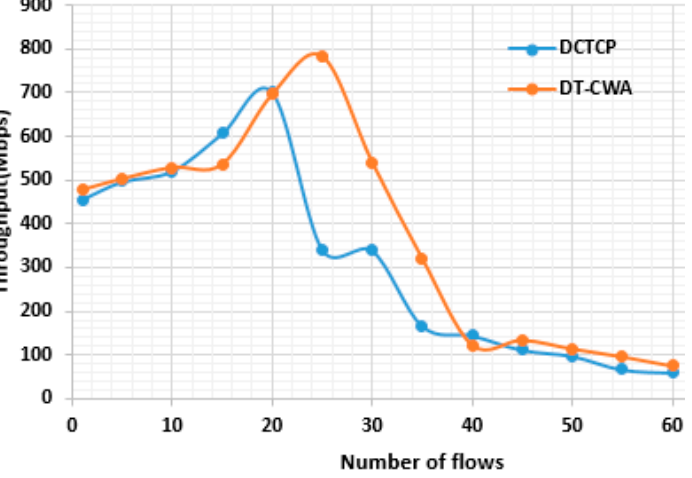
Figure 6. Comparison of throughput.